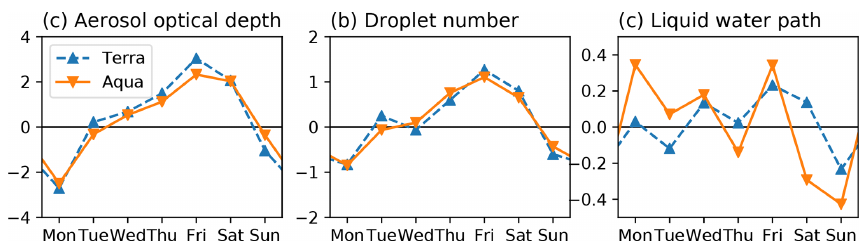
Figure 8. Weekly cycle of (a) AOD, (b) N d , and (c) LWP, in percent deviation from the temporal average, as an average over continental Europe (35 to 70 ◦ N, 10 ◦ W to 30 ◦ E, land only) from MODIS Collection6 retrievals (Levy et al., 2013; Platnick et al., 2017), where N d and LWP are computed assuming adiabatic clouds (Grosvenor et al., 2018). In an update to Quaas et al. (2009), the period from 2003 to 2020 is used for Terra (10:30LT, upward-pointing blue triangles, dashed line) and Aqua (13:30LT, downward-pointing orange triangles, plain